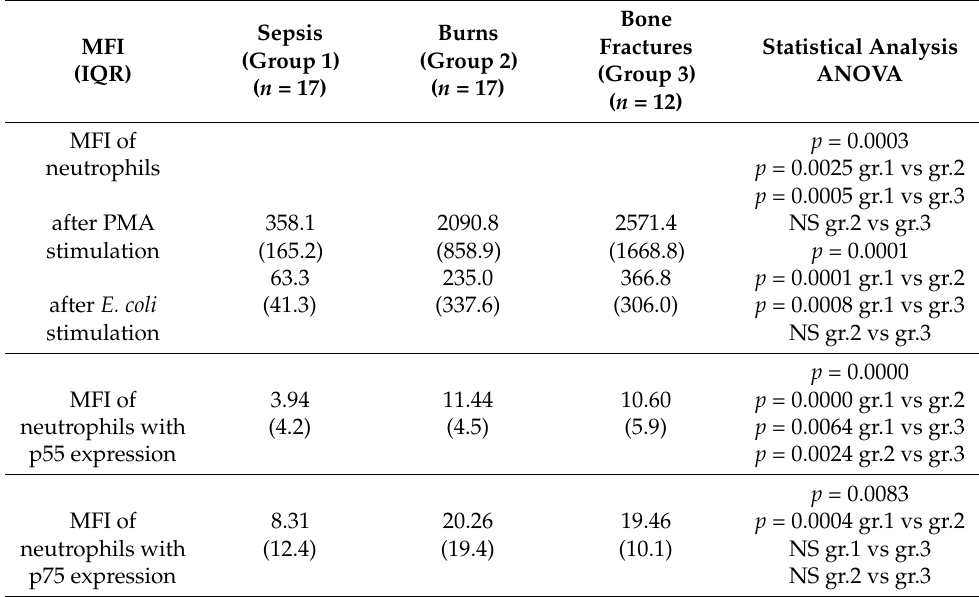
Table 4. Fluorescence intensity of the neutrophils (after treatment and CRP normalization) in the studied groups of children with SIRS.